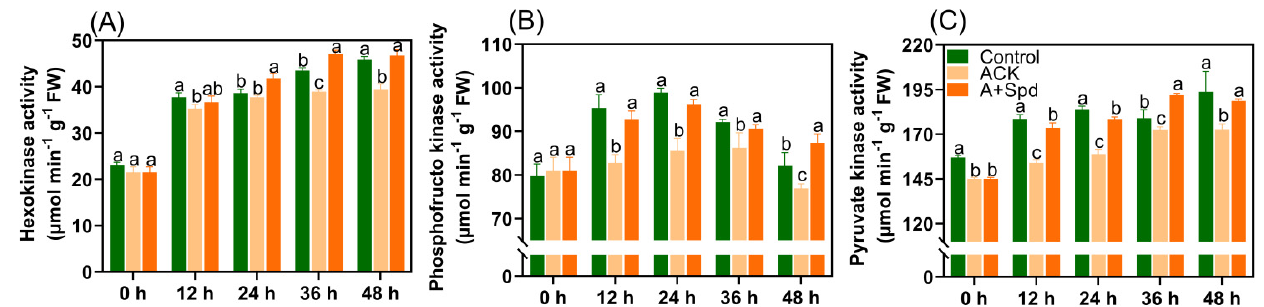
Figure 5. Exogenous Spd increases the activities of key enzymes in EMP during germination of aged seeds. ( A ) The quantitative analysis of Hexokinase activity. ( B ) The quantitative analysis of phosphofructokinase activity. ( C ) The quantitative analysis of pyruvate kinase activity. Control − healthy seeds; ACK − artificially aged seeds; A+Spd − aged seeds with Spd treatment. A total of five time points from 0 to 48 h after germination were performed for each treatment. Different lowercase letters above the bars indicate significant levels of difference among the three treatments ( p < 0.05, Lsd). A 0.05 µ M concentration of exogenous Spd was used.